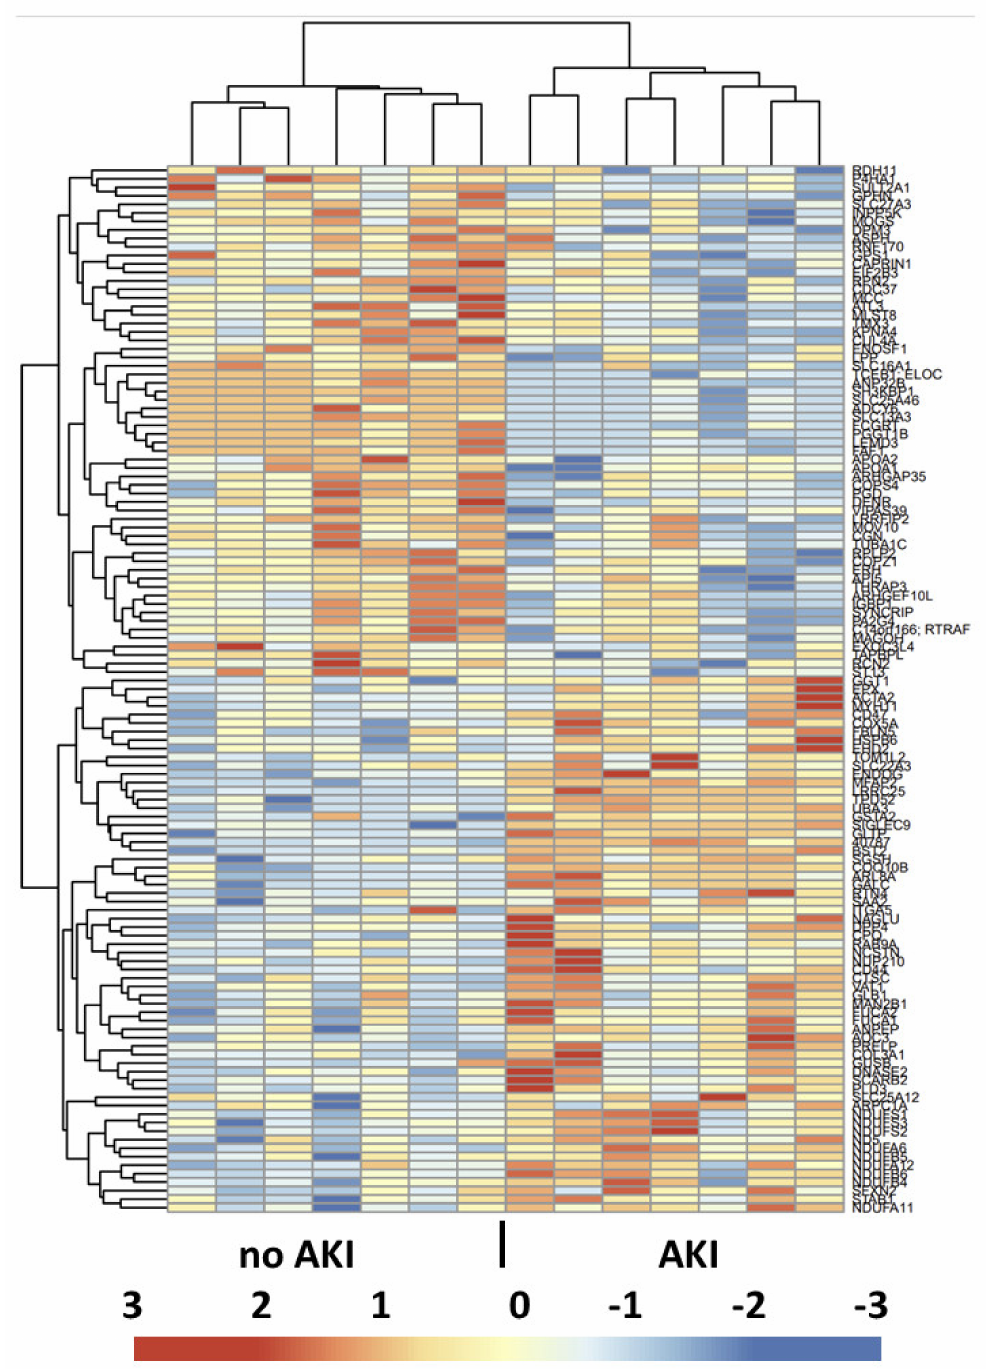
Figure 3. Heat map view and hierarchical clustering of the proteins showing significant differences between the two groups. The horizontal tree indicates the proteins, and the vertical tree indicates the 14 patients analyzed. The color scheme in the cluster analysis is from blue (low) to red (high), and protein identities are listed on the